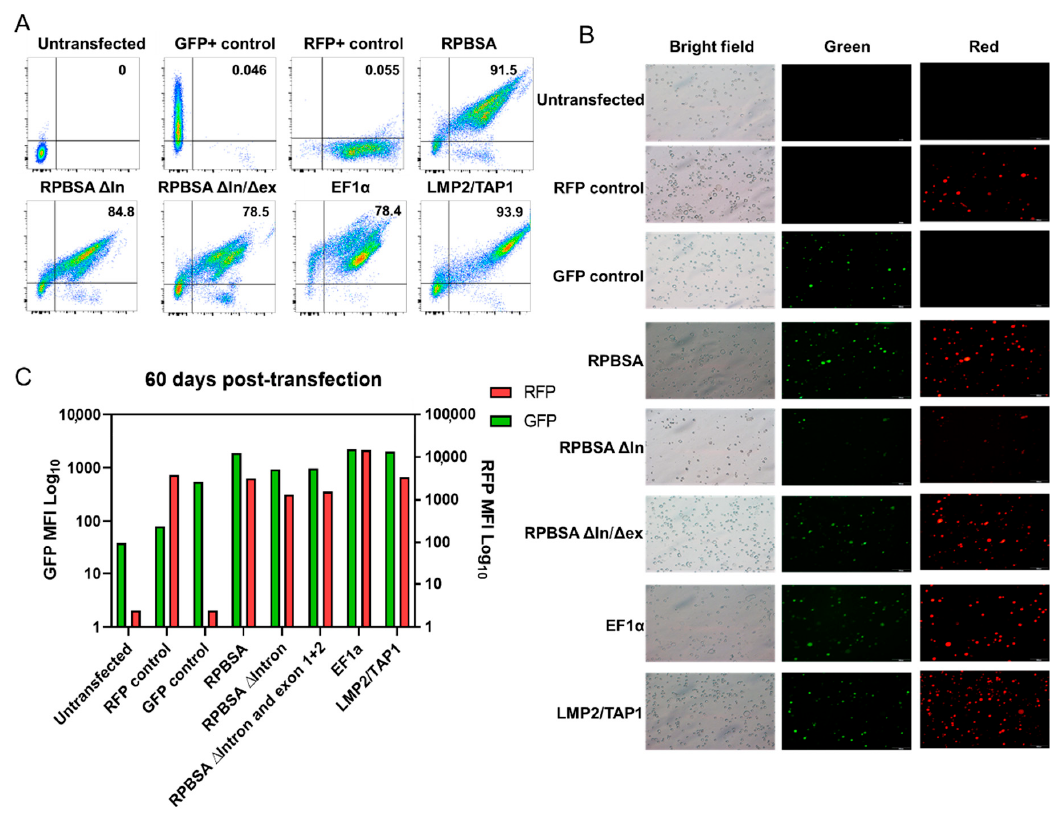
Figure 2. Monitoring maintenance of long-term expression by bidirectional promoters after 60 days. ( A ) Flow cytometry carried out to measure the expression GFP and RFP in Jurkat cells. Cells were subjected to FSc and SSc doublet discrimination. ( B ) Fluorescent microscopy of Jurkat cells expressing GFP and RFP. ( C ) MFI assessment of Jurkat cells for GFP and RFP expression.